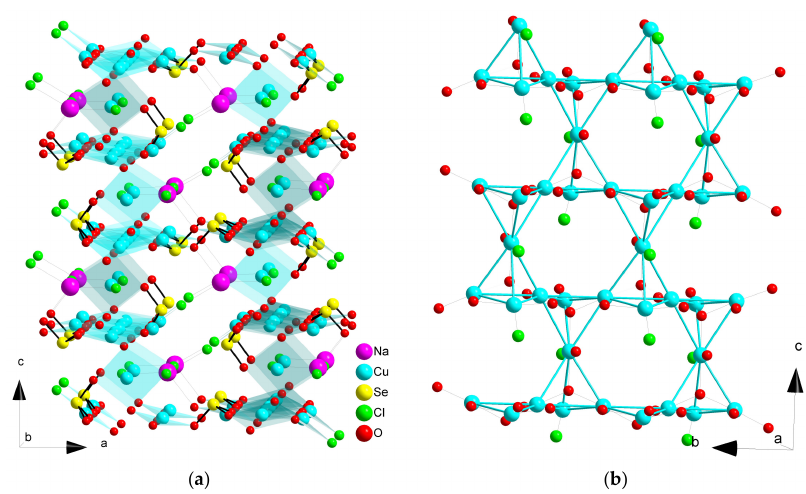
Figure 20. The crystal structure of NaCu 5 (SeO 3 ) 2 O 2 Cl 3 . Two types of [CuO 4 ] and [CuO 3 Cl] plaquettes are shown ( a ); A fragment of the corner shared Cu 4 tetrahedra sublattice layer in the crystal structure of ilinskite like compounds ( b ).